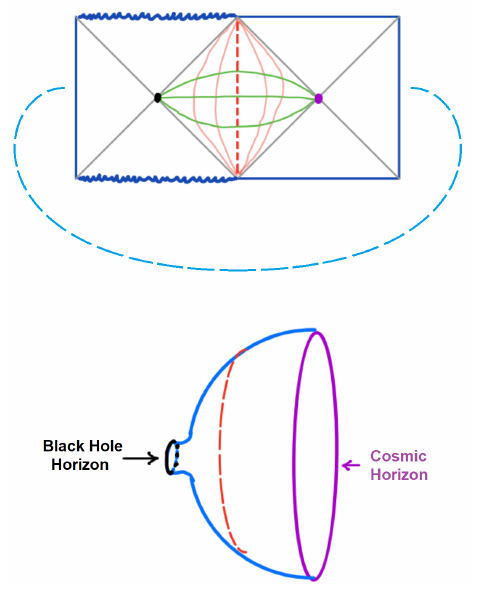
Figure 14. The top panel shows the penrose diagram for a Euclidean Schwarzschild black hole, together with a static patch, which symmetrically encloses the black hole. The black dot on the left is the black hole horizon. The purple dot on the right is the cosmic horizon. The lower panel shows a spatial slice of the region between the two horizons. The dashed red line indicates the static position of a 2-sphere somewhere between the two horizons.